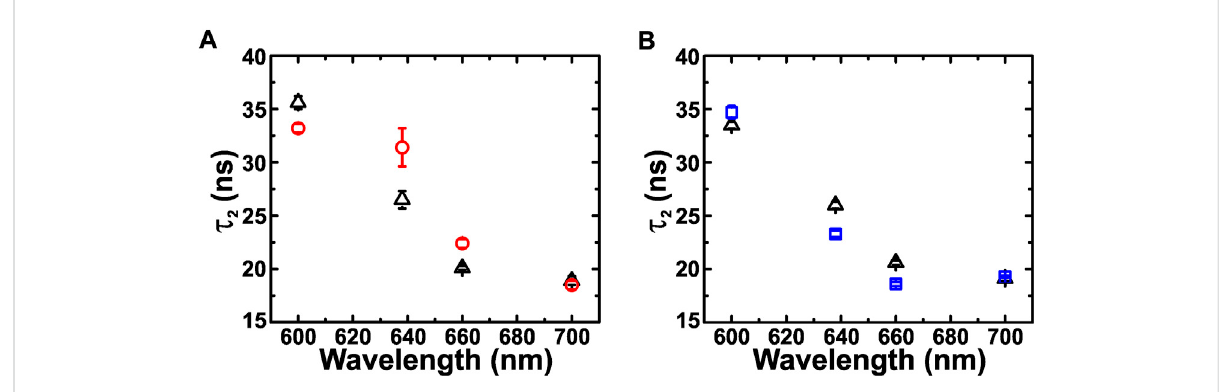
FIGURE 8 (A) The wavelength dependence of τ 2 for the reference (triangles) and sample B (circles) measured in the rear-side geometry. corresponding values of τ 2 for the reference (triangles) and sample B (squares) measured in the front-side